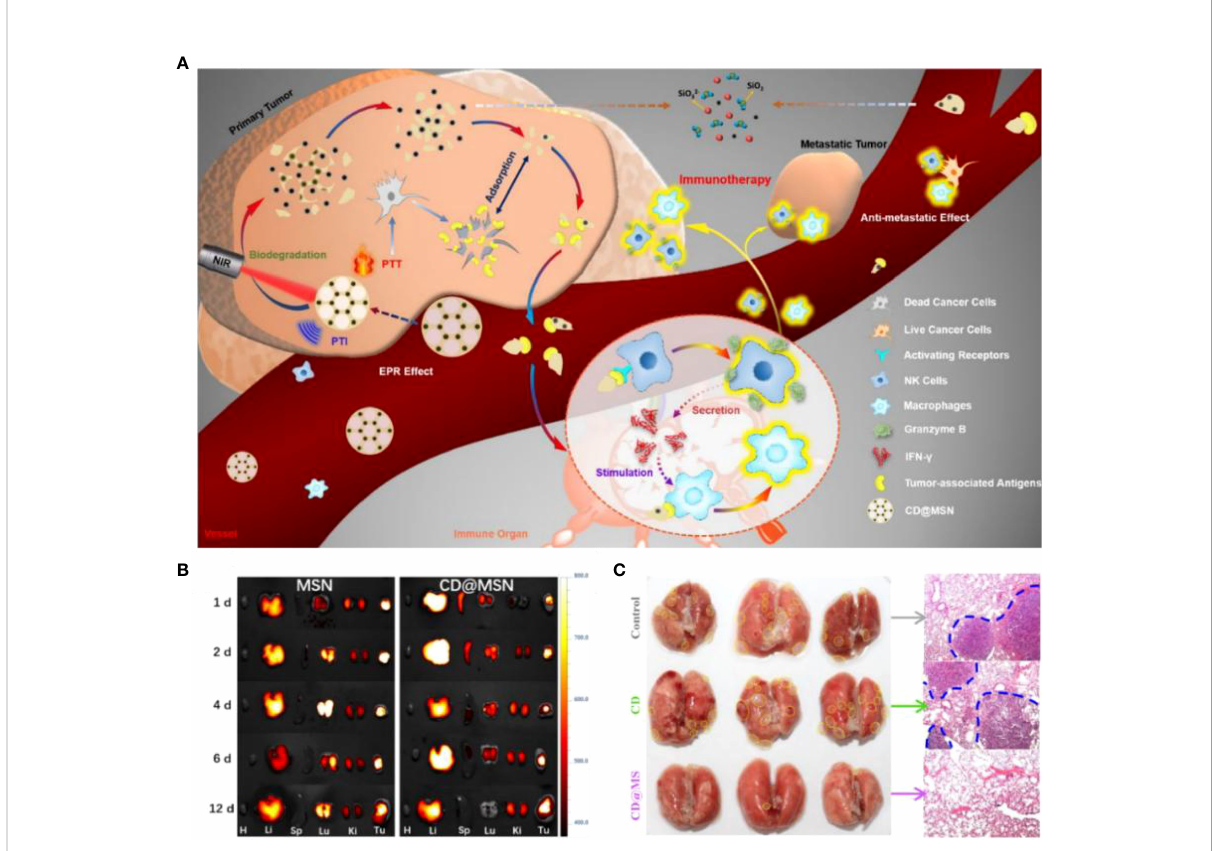
FIGURE 3 (A) . Schematic diagram of biodegradable CD@MSN combined with PTI and PTT for tumor immunotherapy. (B) Fluorescence images of major organs (heart, liver, spleen, lung and kidney) and tumors at different time points after intravenous injection of Cy5-MSN and Cy5-CD@MSN, respectively. (C) Photographs of the lungs of each group after 14 days of administration of different treatment regimens to the tumor-bearing mice (yellow dashed lines indicate the foci of metastatic tumors) and corresponding H&E-stained sections (blue dashed lines indicate the borders of metastatic tumors) (77). Reprinted with permission from Ref. (77). Copyright© 2019, copyright Qian et